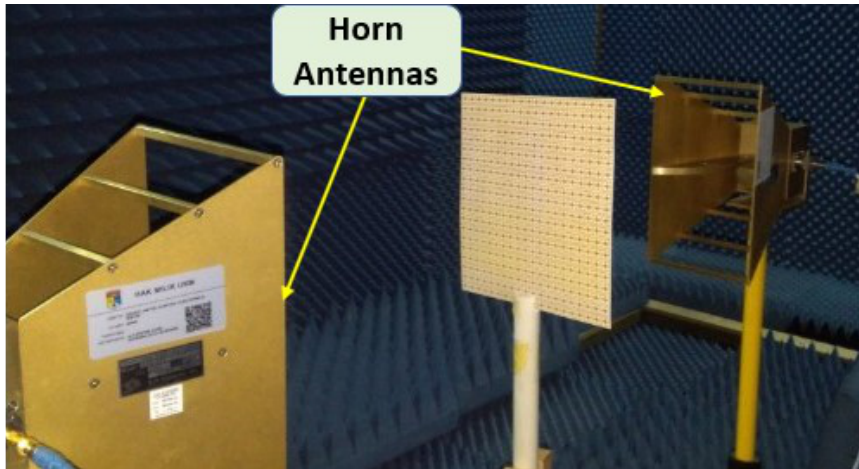
Figure 13. Photograph of the far-field measurement setup.